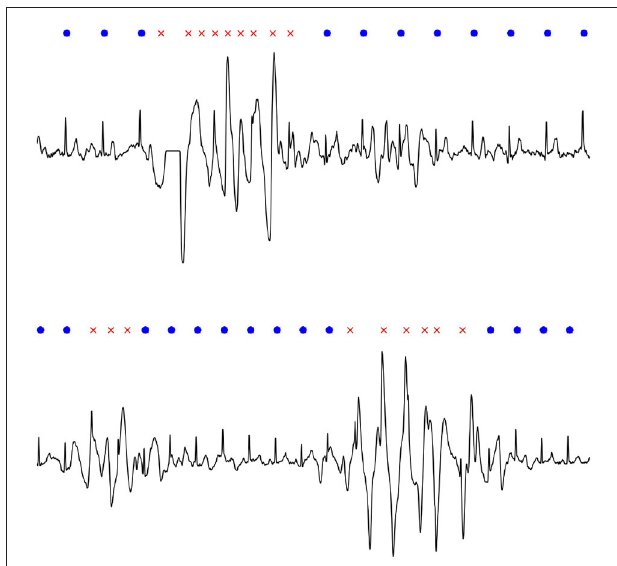
FIGURE 5 | Without quality control, these two recordings are falsely detected as AF due to the rhythm irregularity caused by transient noise. By identifying and excluding transients (red crosses) before AF detection, the two recordings are correctly detected as non-AF; true beat detections are indicated with blue dots.